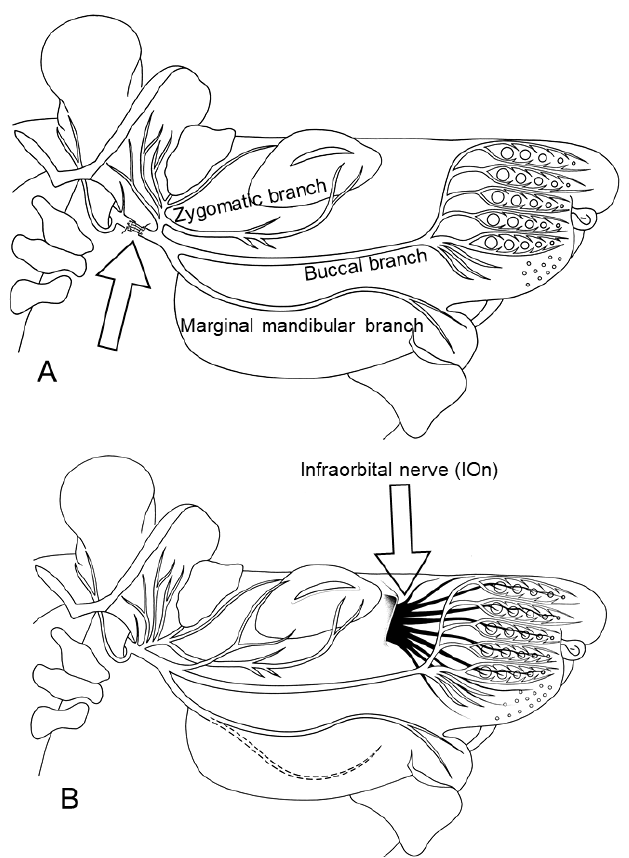
Figure 2. Schematic drawings illustrating the infratemporal portion of the facial nerve (Fn), and ( A ) the site of its transection and suture in one experimental rat group, as indicated by an arrow and ( B ) the close relationship between the peripheral fascicles of the Fn and those of the infraorbital nerve (IOn). The arrow shows the site of excision of the IOn in the experiments described in Section 4, demonstrating that afferent connections are important in improving functional recovery of whisking behavior and reducing polyinnervation of the motor endplates. The drawings are from Pavlov et al. (2008) [41].